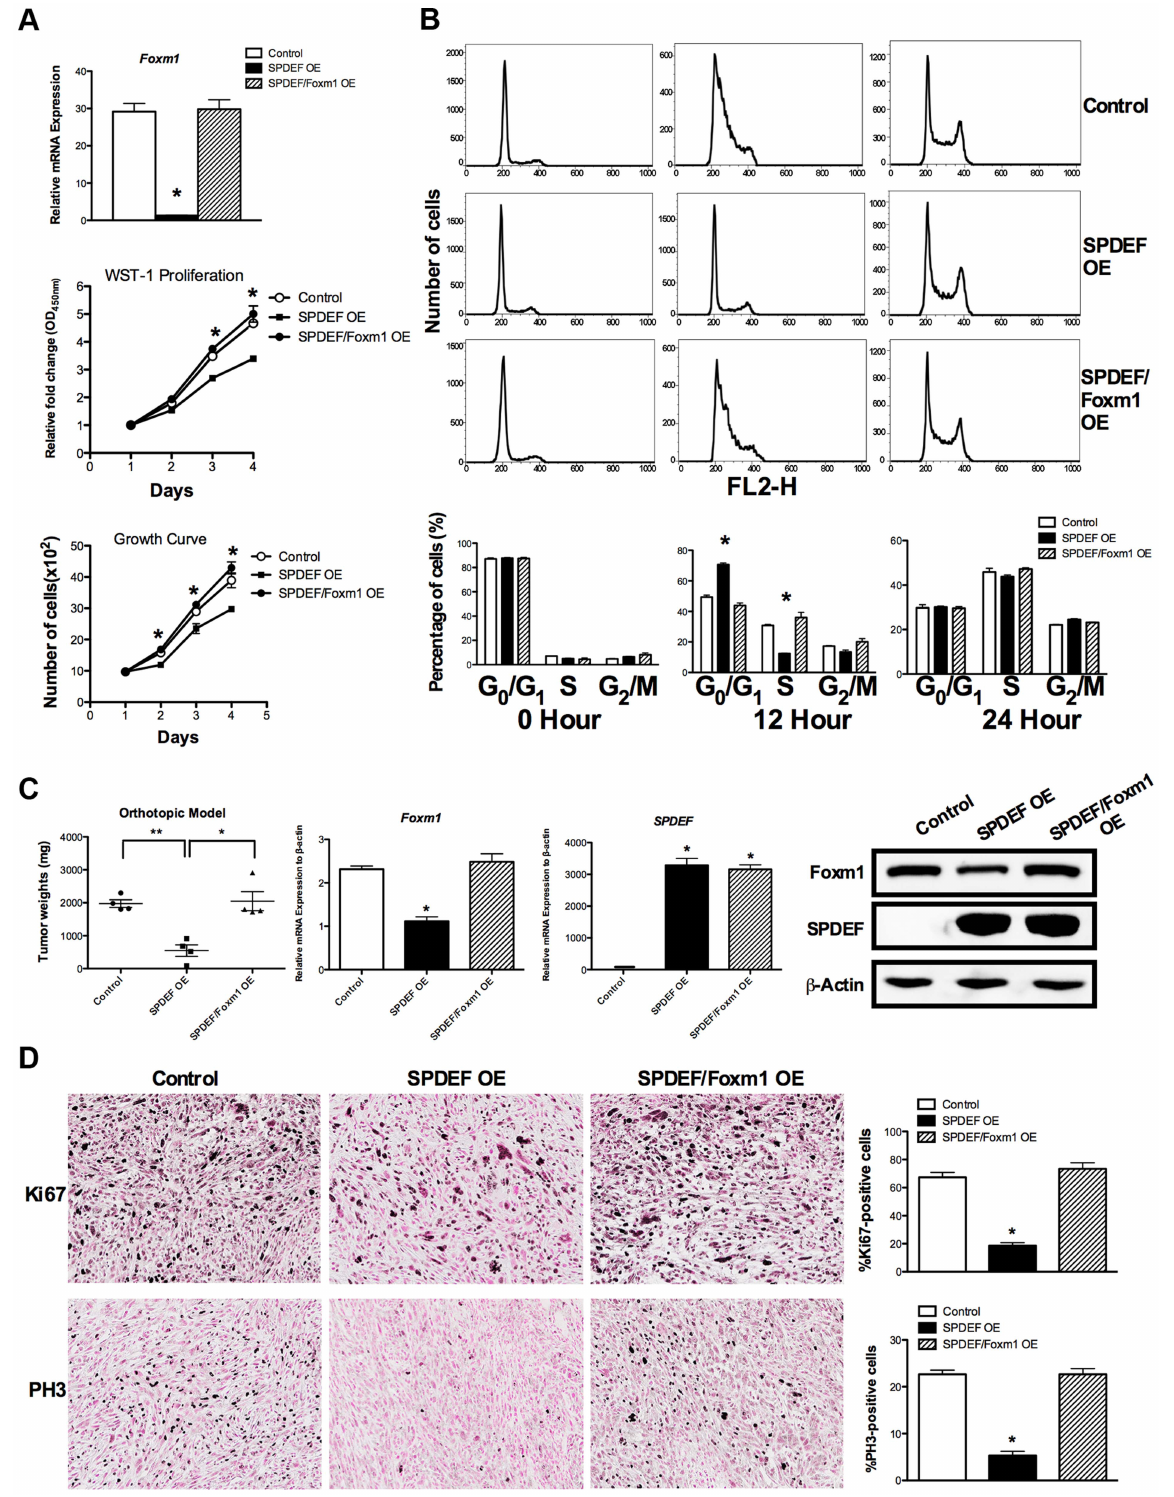
Figure 7. Re-expression of Foxm1 in the SPDEF-positive prostate adenocarcinoma cells restored tumor cell proliferation invitro and invivo . We used SPDEF-overexpressing prostate adenocarcinoma TRAMP C2 cells (SPDEF OE cells) to stably express Foxm1 (SPDEF/Foxm1 OE cells). A . Foxm1 mRNA levels were determined by qRT-PCR. Growth curves demonstrated that re-expression of Foxm1 in SPDEF OE cells restored the growth of these cells in culture. B . Flow cytometery shows that the re-expression of Foxm1 in SPDEF OE cells increased entry of synchronized cells into S phase at 12 hours after serum addition in vitro . C . In orthotopic mouse model of prostate cancer, re-expression of Foxm1 in SPDEF- overexpressing cancer cells restored tumor sizes that have been decreased after SPDEF expression (left panel). Foxm1 and SPDEF mRNAs in tumor tissues are shown by qRT-PCR (middle panels). Protein levels of Foxm1 and SPDEF are shown by Western blot (right panel). D . Re-expression of